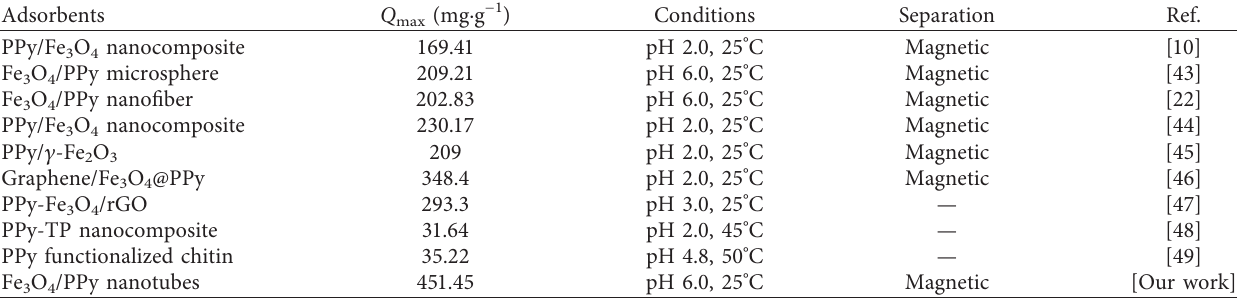
Table 5: Comparison of Q max of different sorbents for